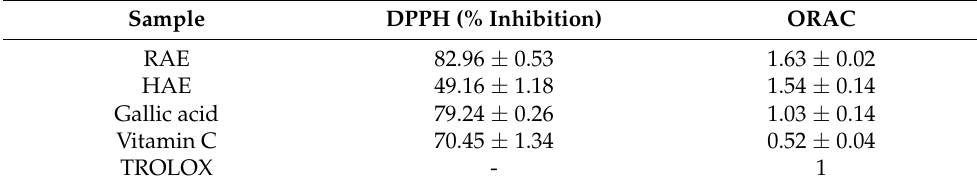
Table 4. Radical scavenging capacity of MS extracts by DPPH and ORAC